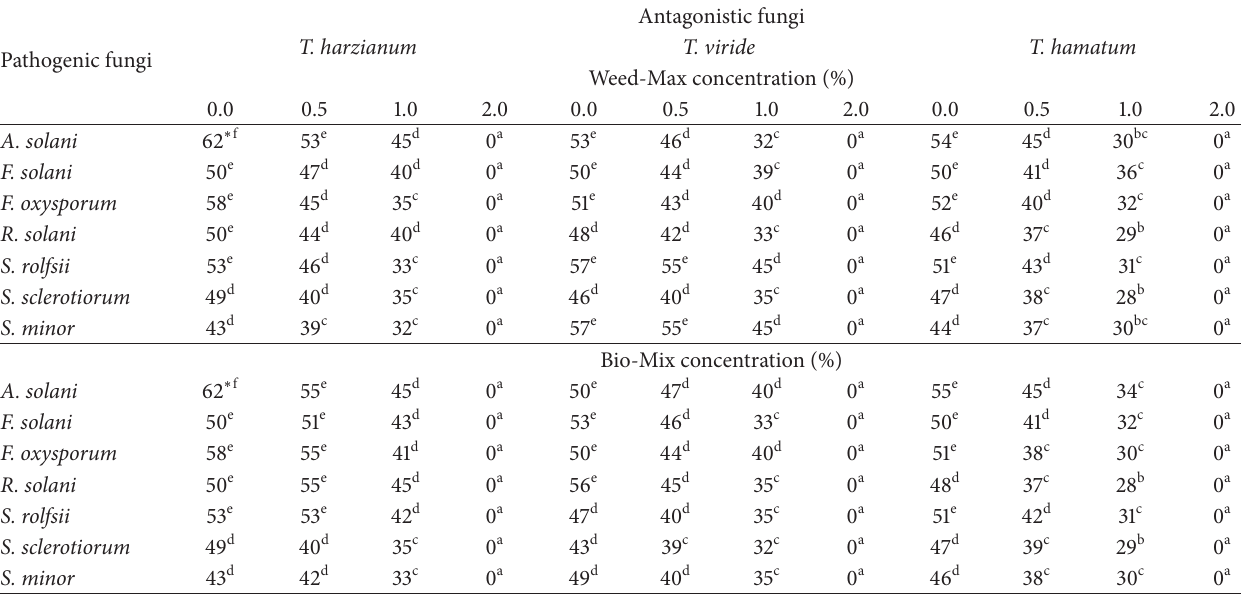
Table 3: Effect of Weed-Max and Oligo-X concentrations on the antagonistic ability of fungi against some soil-borne pathogenic fungi in vitro .